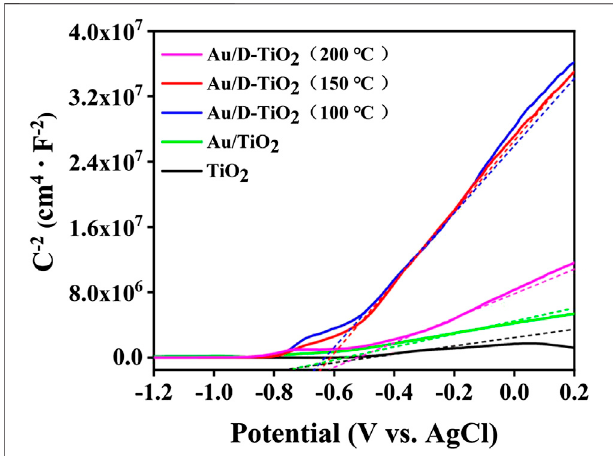
FIGURE 6 | The Mott – Schottky curves of using Ag/AgCl as a reference electrode of TiO 2 , Au/TiO 2, and Au/D-TiO 2 (The D-TiO 2 were treated at 100 ° , 150 ° , and 200 ° C, respectively).